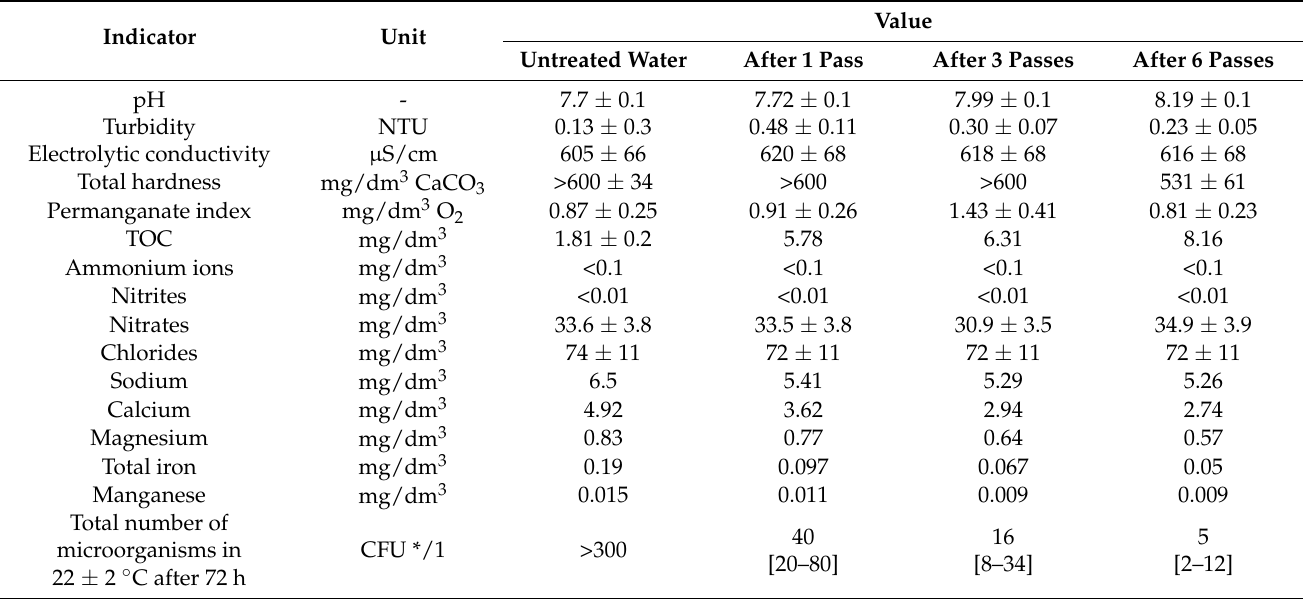
Table 7. Physical, chemical and microbiological parameters of the aqueous solutions before and after the application of nonthermal